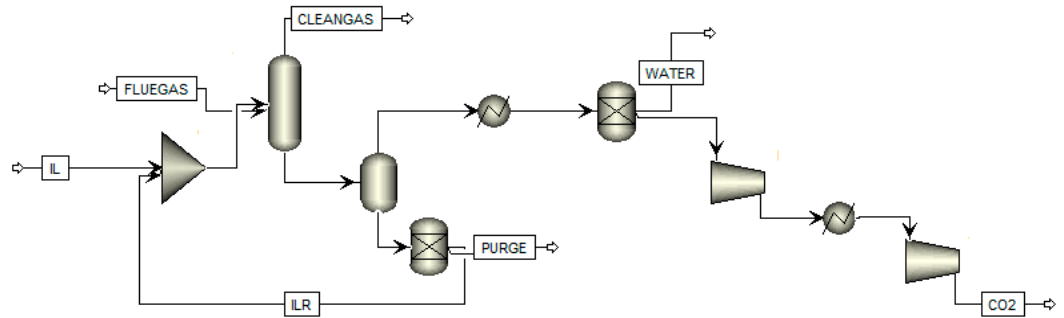
Figure 1. Process scheme of carbon dioxide absorption process from flue gas with IL in Aspen Plus ® environmental. Table 1. Composition of the analyzed flue gas [37]